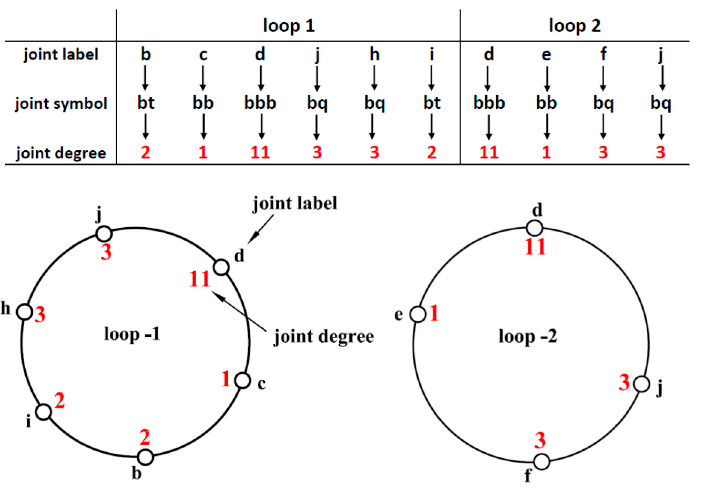
Figure 2. Generation of joint degrees for loops (1 and 2) for the 9-link kinematic chain shown in Figure 1. Step 5 Joint Degree Array